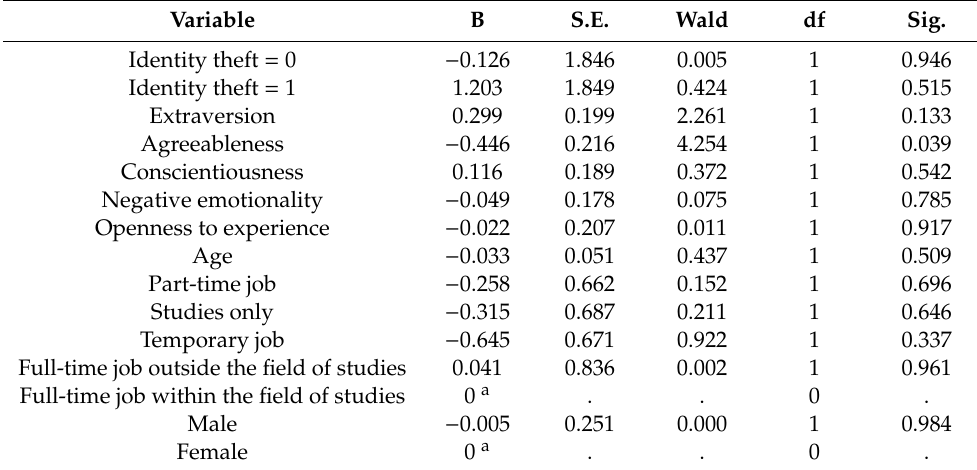
Table 1. Full Model 1—Identity theft: ordinal logistic